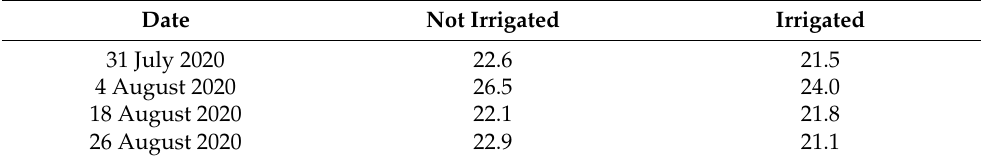
Table 6. The average absolute temperature [ ◦ C] from pictures captured using the thermal camera at four points (irrigated and non-irrigated; soybean). The value for each point represents the average of three to six absolute points around the